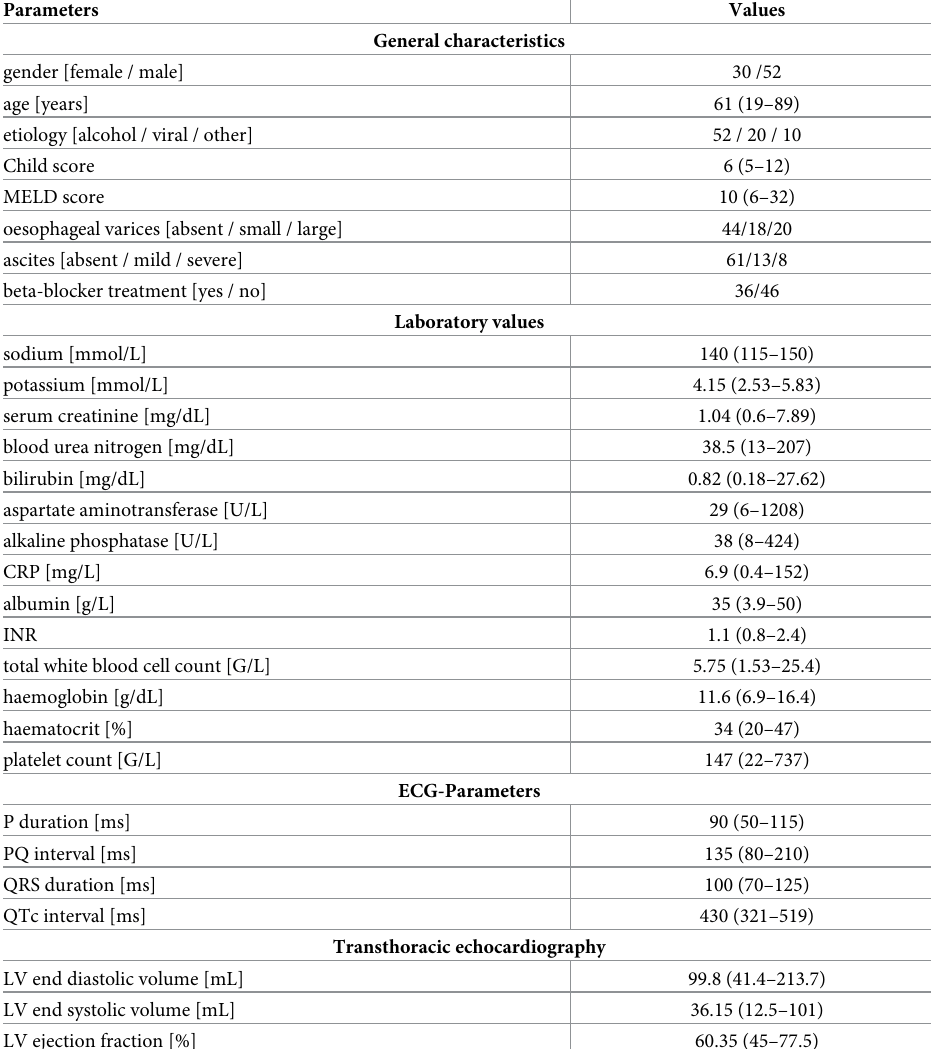
Table 1. Baseline parameters of the patients (n =